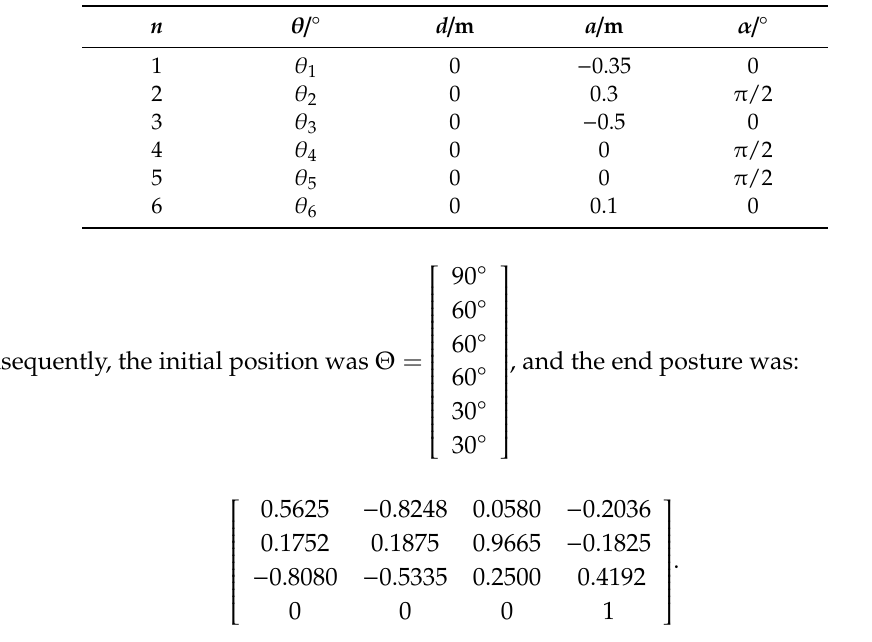
Table 12. The DH parameters of Bot 1 after changing the